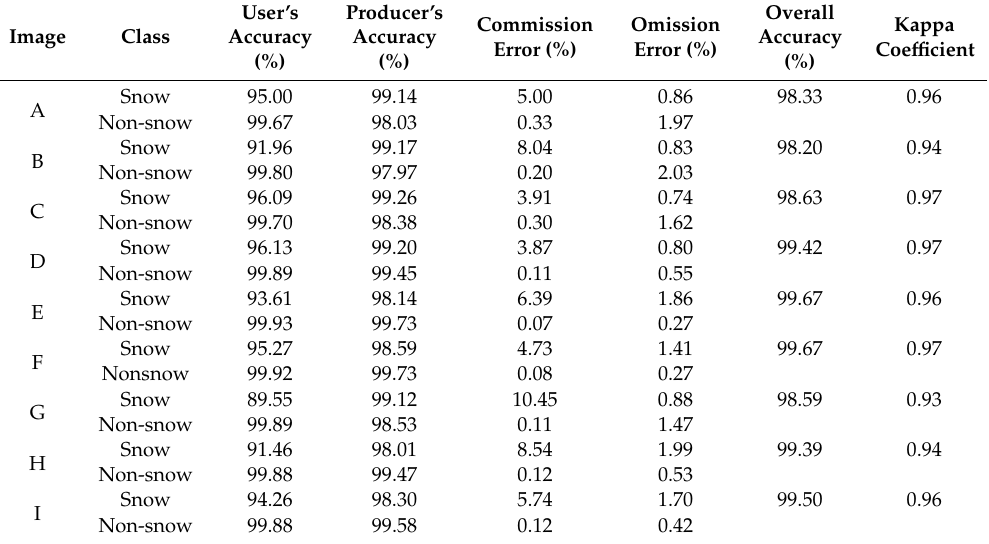
Table 2. Summary of the accuracies for the developed method over nine images.